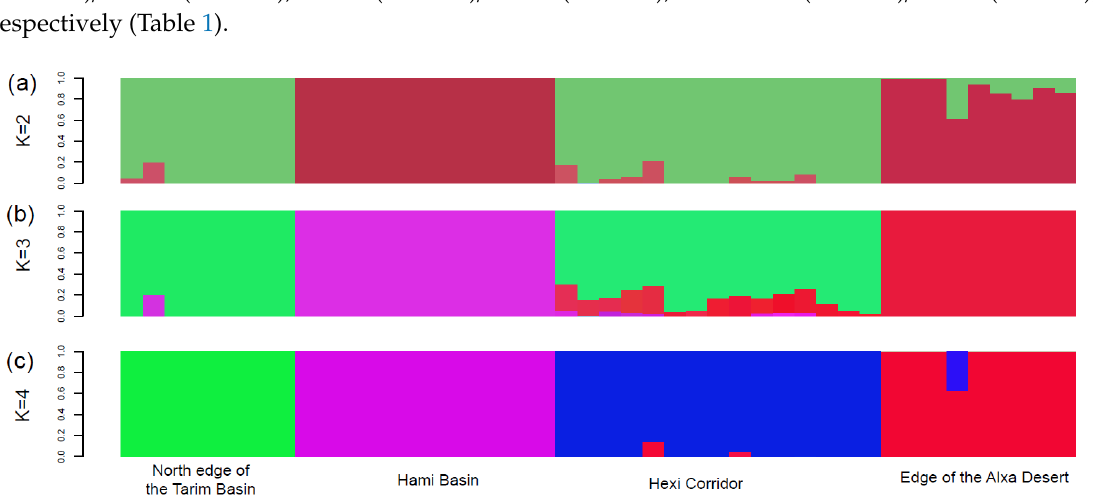
Figure 3. Genetic clustering of the 14 sampled Gymnocarpos przewalskii populations based on the genome-wide SNPs dataset. The patterns are shown with different K values at K = 2 ( a ), K = 3 ( b ), and K = 4 ( c ).